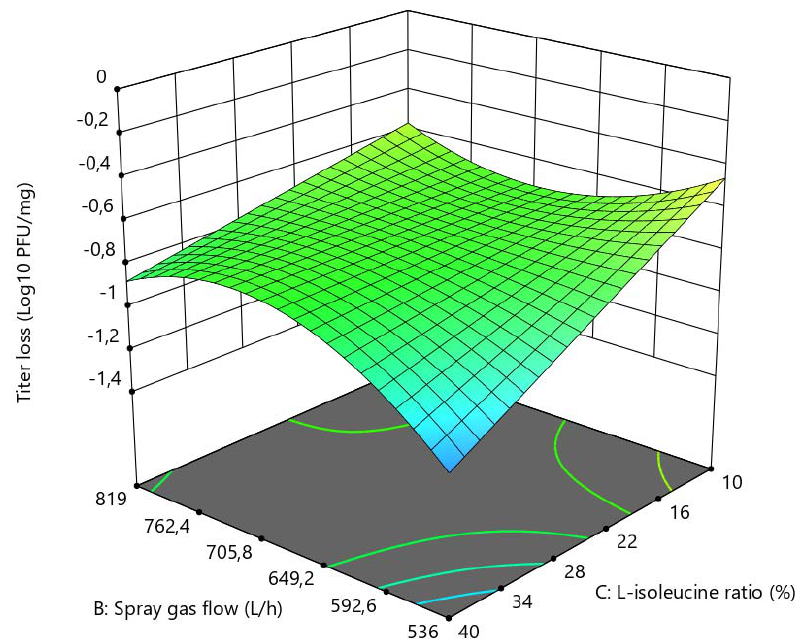
L-isoleucine ratio (%) and spray gas flow Figure 4. 3D surface graph showing bacteriophage 14 ‐ 1 activity (log 10 pfu/mg), in relation to L ‐ iso ‐ leucine ratio (%) and spray gas flow (L/h).